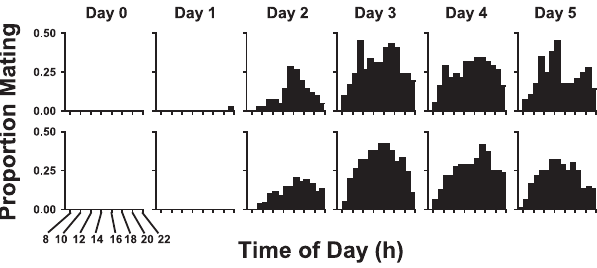
Figure 2. Occurrences of mating behavior with age at two density conditions. The proportion of flies mating under low (top row) and high (bottom row) density conditions with respect to adult age, in days, and time of day during the photophase of the 15:9 hour light:dark cycle. Day 0 is the day of eclosion.